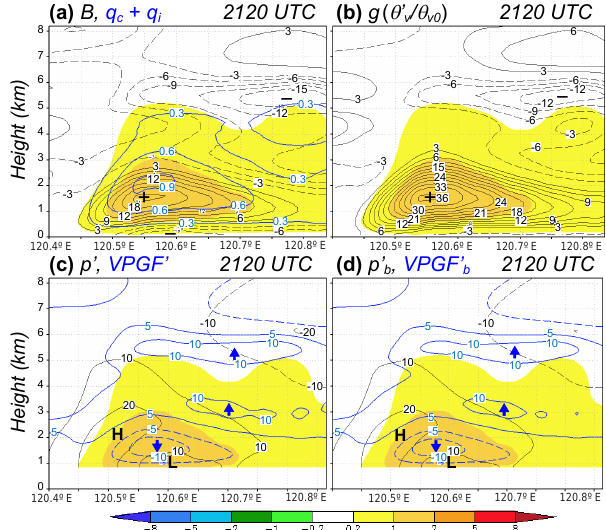
Figure 18. (a, b) As in Fig. 15a and b, but showing w (color) and (a) B (black contour) and mixing ratio of cloud particles (blue con- tour) and (b) g(θ (cid:48) v /θ v0 ) along the WSW–ENE segment through C1 at 21:20UTC, 11 June 2012. (c, d) As in Fig. 16a and b, but show- ing w and (c) p (cid:48) (black contour) obtain from the relaxation method and − (∂p (cid:48) /∂z)/ρ 0 (blue contour) and (d) p (cid:48) and its vertical PGF b along the segment as in panels (a, b) at